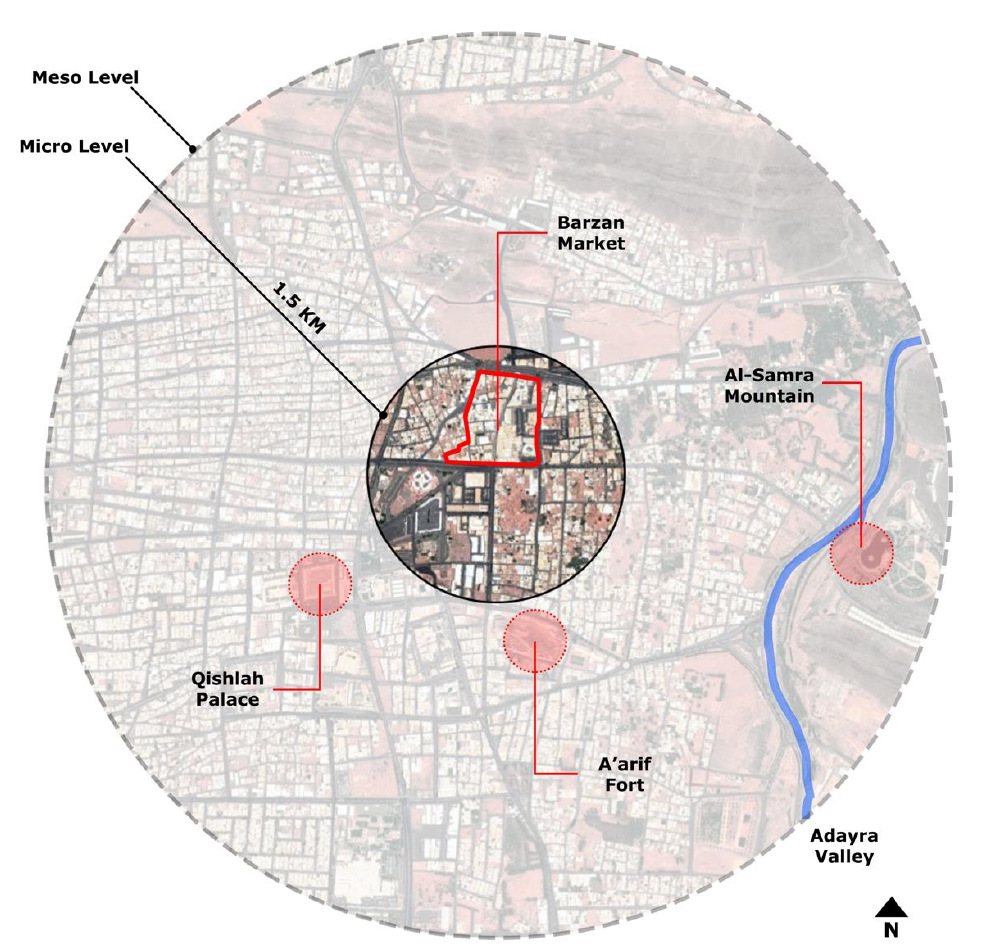
Figure 10. Micro and meso levels of the city center showing other significant historical landmarks. Source: Authors.